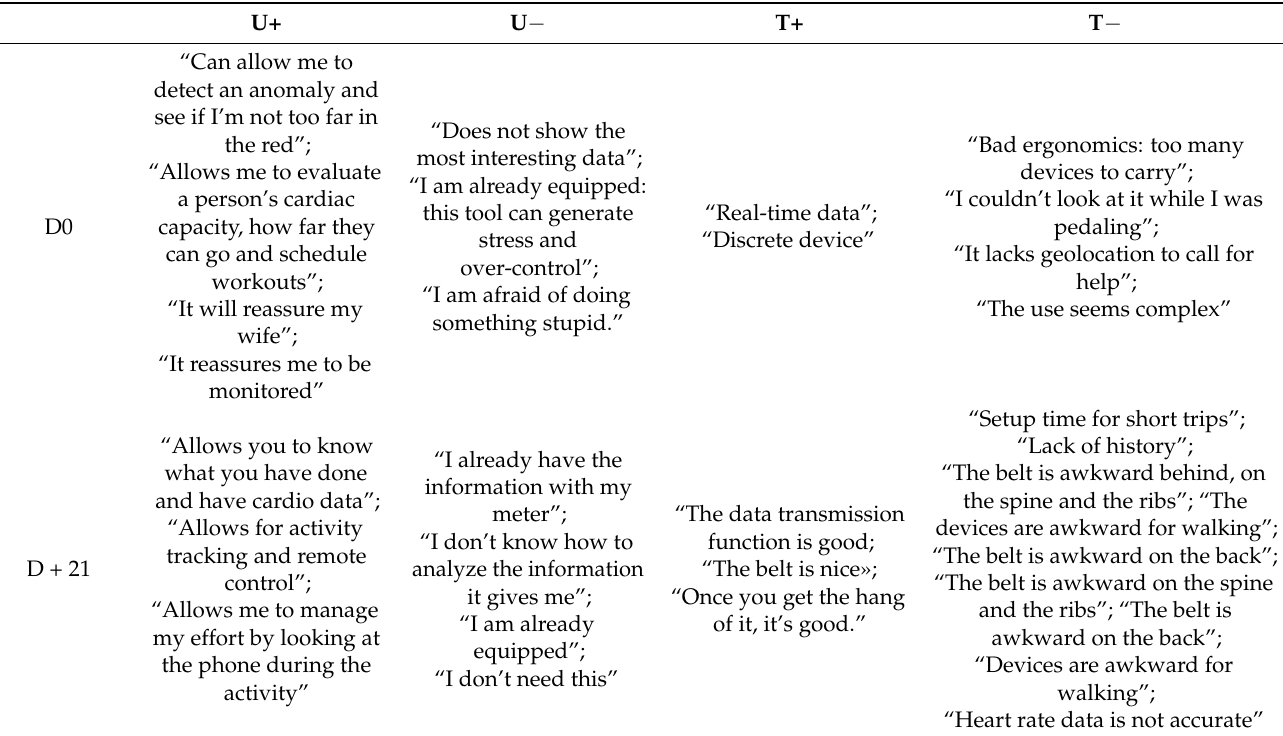
Table 1. Examples of Verbatim by Category and Response Time—SHERPAM project.